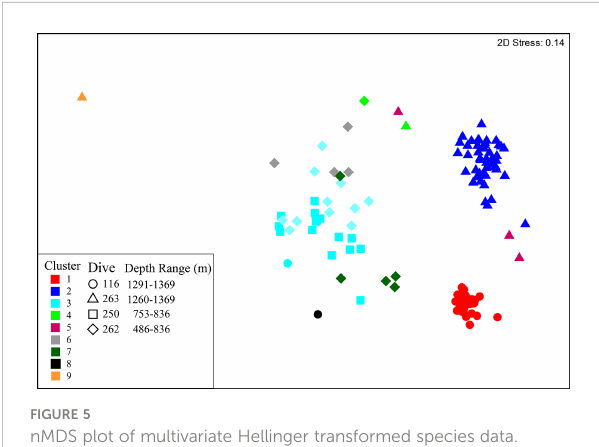
FIGURE 5 nMDS plot of multivariate Hellinger transformed species data. Samples are coloured to represent the nine clusters identi fi ed by hierarchal clustering analysis. Shapes denote the dive from which samples were